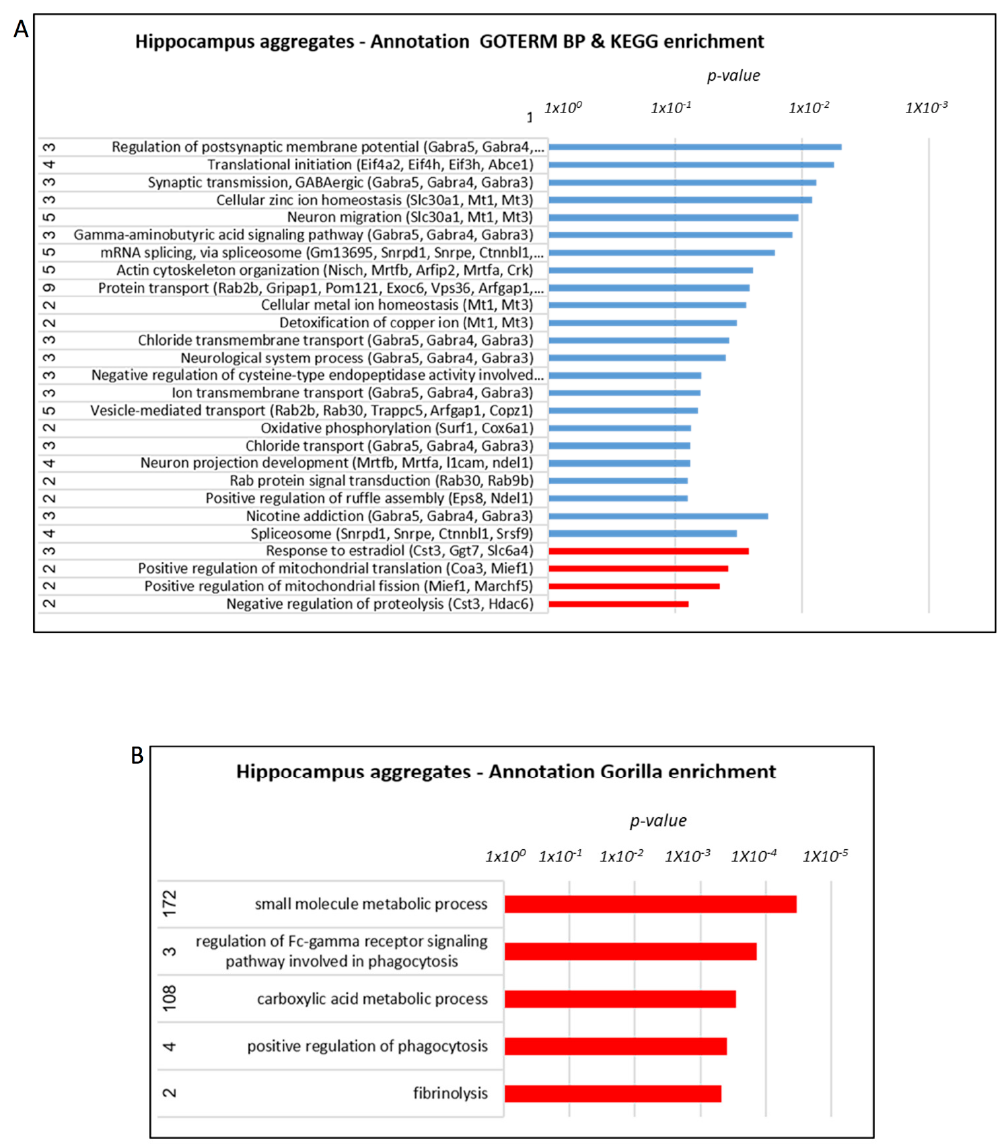
Figure 6. Proteomics analysis of the hippocampus: annotation analysis of hippocampus aggre- gates. ( A ) KEGG/GOTERM (names of affected proteins presented in brackets; full names of proteins are presented in Table S1 and Supplemental-hippocampus-aggregates-proteomics-excel). ( B ) Gorilla enrichment AD > treated AD—marked in blue, AD < treated AD—marked in red.